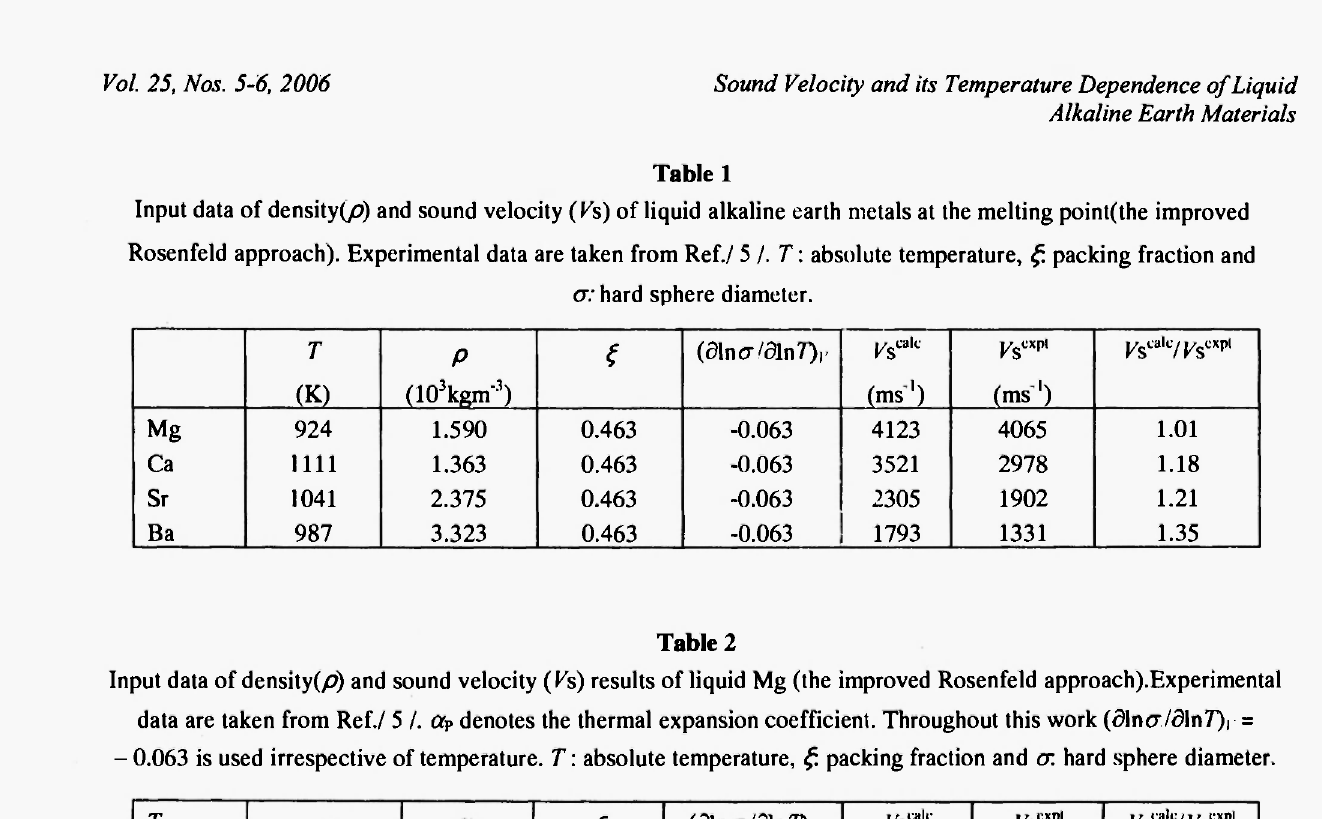
Input data of density(/?) and sound velocity (Ks) of liquid alkaline earth metals at the melting point(the improved Rosenfeld approach). Experimental data are taken from Ref./ 5 /. Τ : absolute temperature, ξ. packing fraction and σ: hard sphere diameter.